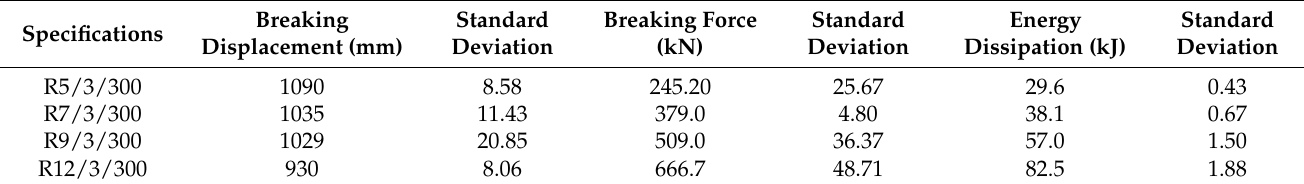
Table 2. Breaking force and breaking displacement of ring nets with different specifications under a static punching condition.